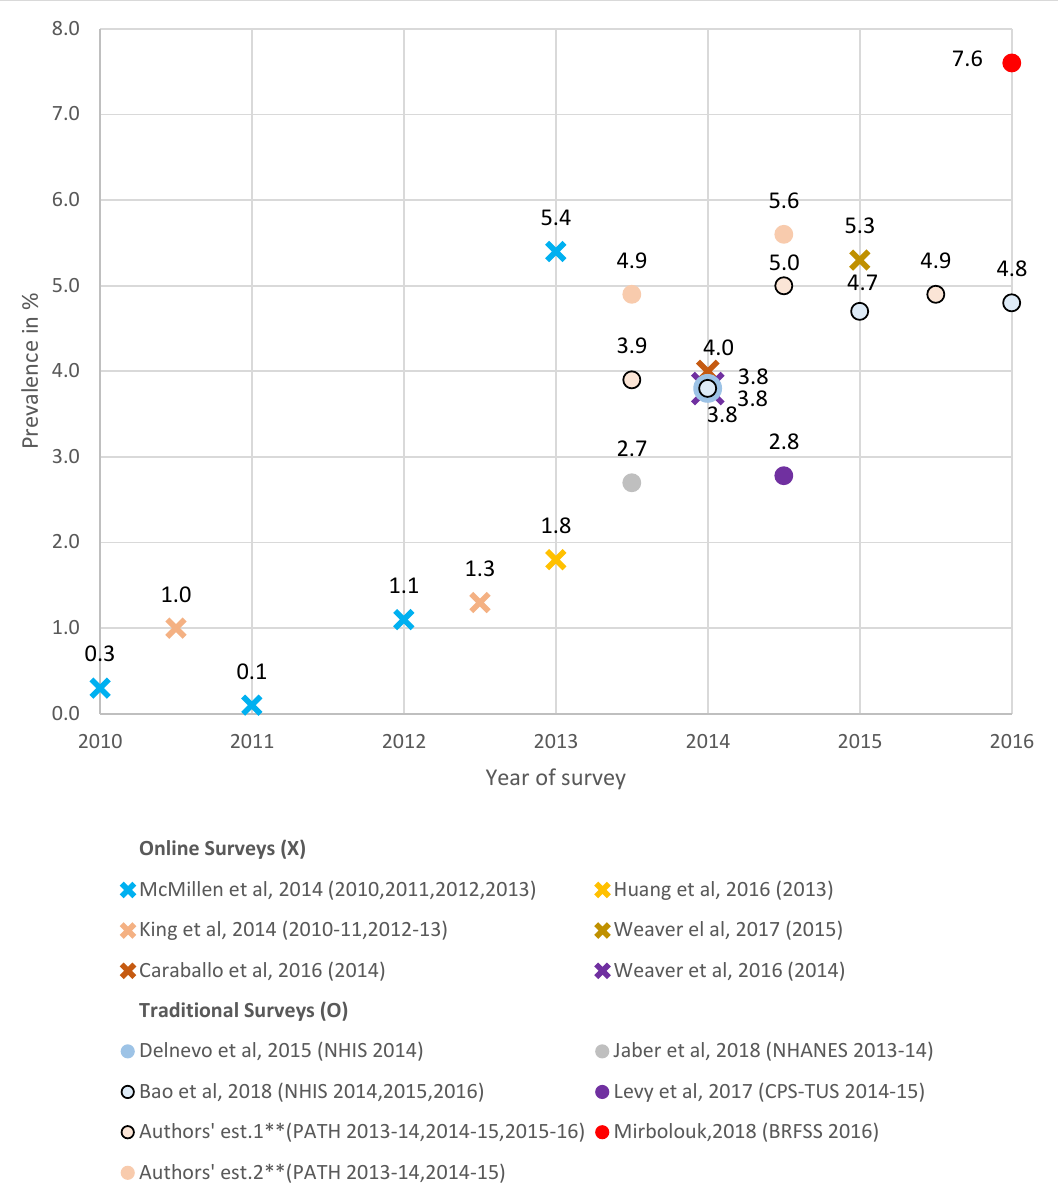
Figure 3. The prevalence of current e-cigarette/ENDS use among adult former smokers, online and traditional survey estimates, * 2010–2016. * The estimates from online surveys are indicated by an X, and the estimates from traditional surveys are indicated by a circle. The legend adopts the format “author’s name, publication year (survey name and year(s)),” and the names of all online surveys are omitted. For surveys that collected data over a two-year period, we plotted the estimates in the mid-period. ** Authors’ estimate one is measured by daily/nondaily ENDS use, and authors’ estimate two is measured by past-30-day ENDS use.